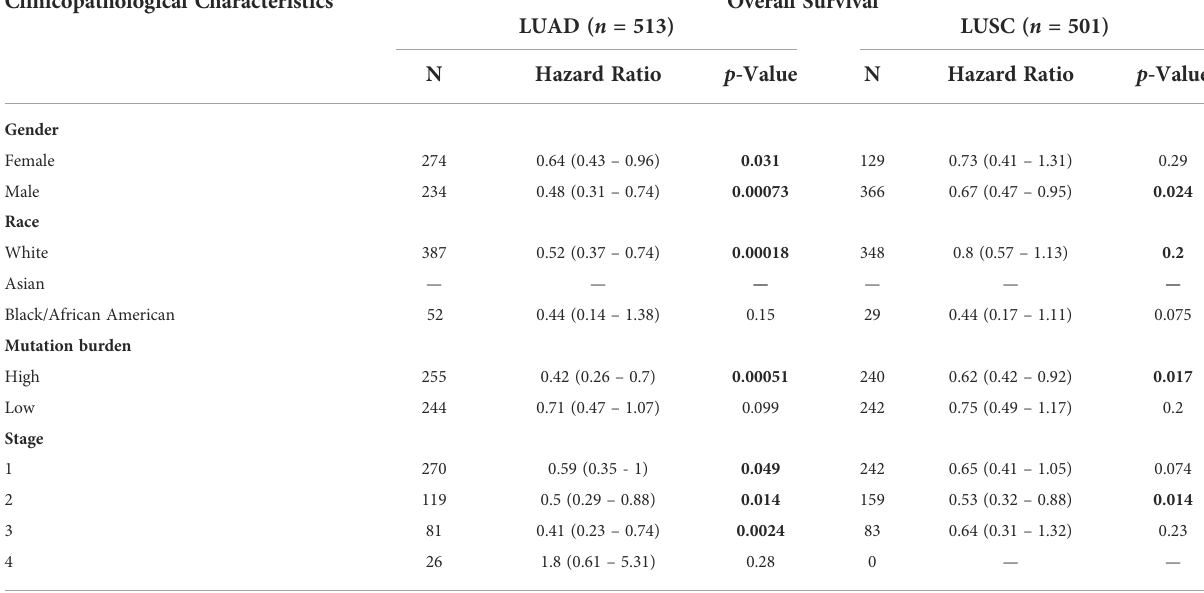
TABLE 1 Correlation of the mRNA expression level of SIRT2 in different stage and clinical prognostic potential in lung cancer with different clinicopathological factors. Clinicopathological